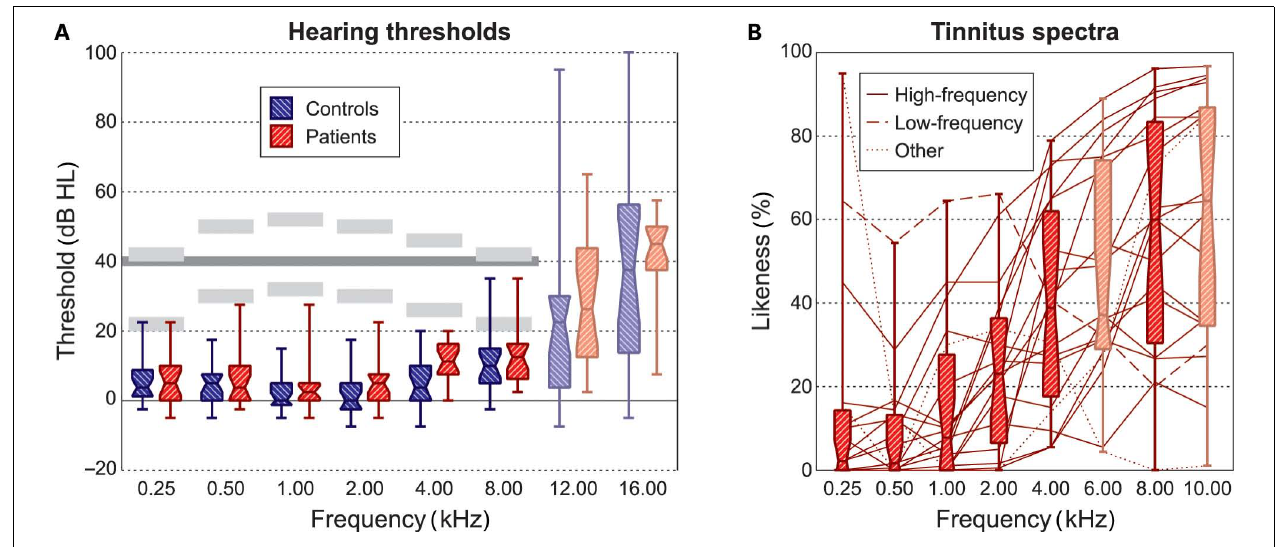
(B) Patients performed a tinnitus spectrum test in which they indicated the subjective “likeness” to their tinnitus percept of a range of sound stimuli with varying center frequencies.The majority of subjects showed high-frequency tinnitus (solid; likeness increasing with frequency); one subject showed a low-frequency tinnitus (dashed; likeness decreasing with frequency); two subjects showed a spectrum that could not be classified as high- or low-frequency (dotted; with a peak or a dip at intermediate